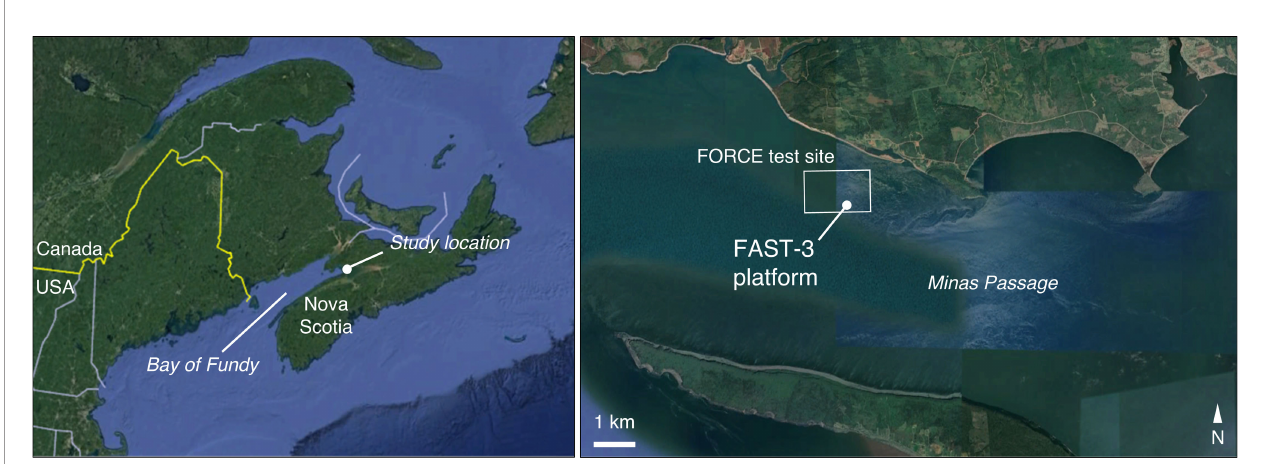
FIGURE 1 | Study location in the Minas Passage of the Bay of Fundy, Canada. The location of Minas Passage is indicated by the fi lled circle in the left-hand panel, and the study site is shown on the right.